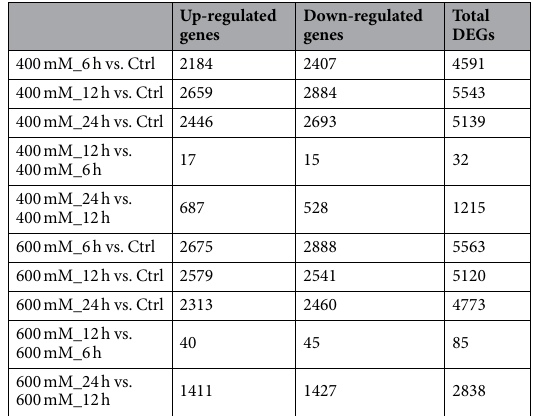
Table 1. DEGs identification in P . euphratica response to salt